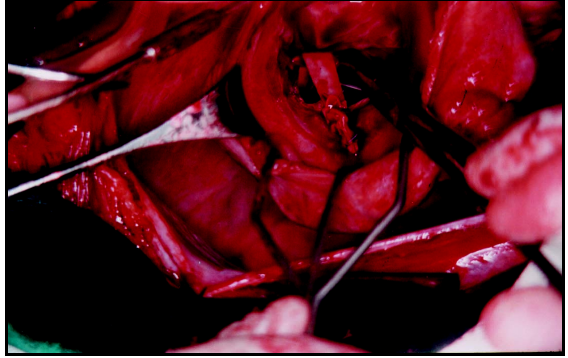
Fig. 4 - Nota-se a sutura da fenda na cúspide anterior e a plástica à Revuelta. Em detalhe a “tira” de pericárdio bovino sustentan- do a cúspide anterior.